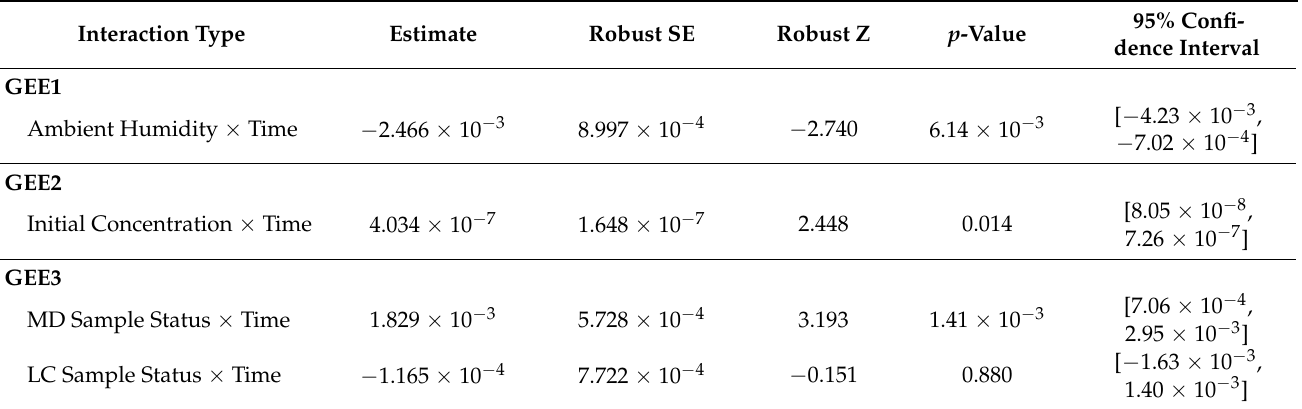
Table 4. Parameter estimates, standard errors, significance, and confidence intervals for interaction terms estimated using GEE, using a Gaussian distribution with a log-link function. For GEE 3, the p -values are compared to a Bonferroni-corrected α =